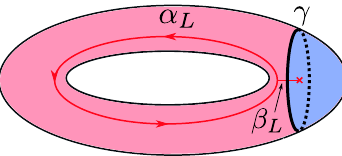
Figure 5 . The space of states on T 2 with a single patch (with connected boundary) of the R topological phase. A generic state can be heuristically thought of as being produced by a the interior path integral with an anyon (cid:11) L running around the non-contractible cycle of the torus. If the identity irrep of the R phase can branch to a non-trivial (cid:13) at the interface then it may be possible for it to pair with a (cid:12) L which can fuse with the interior